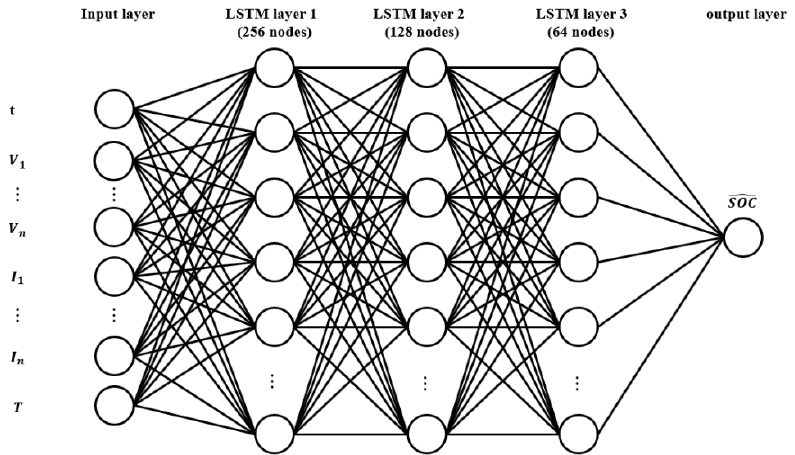
Figure 9. Structure of the LSTM for SOC estimation.